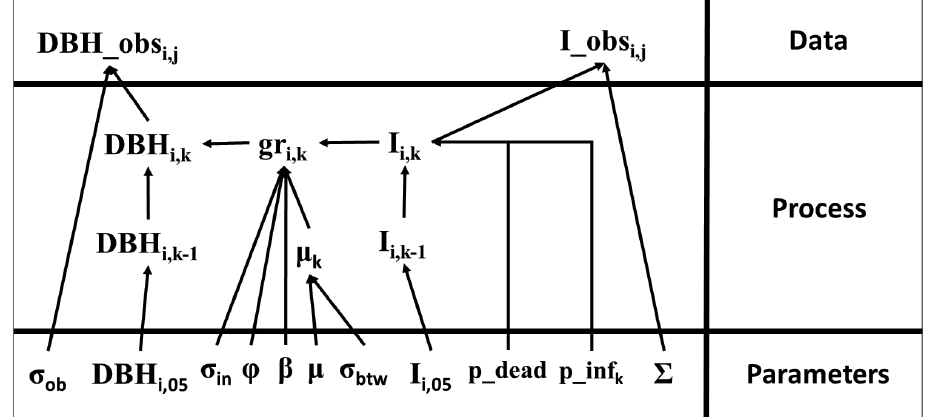
Figure 3. Full model diagram for the analysis following Hobbs and Hooten [43]. 1 ≤ i ≤ 206 is the tree ID number and 05 ≤ k ≤ 19 is the year after